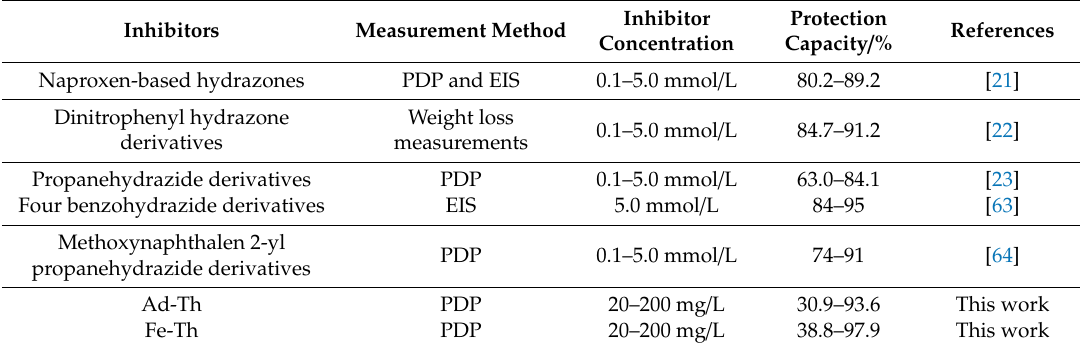
Table 5. Comparison of the protection capacity of Ad-Th and Fe-Th molecules with the earlier reported findings based on other hydrazone derivatives as inhibitors for steel corrosion in acidic